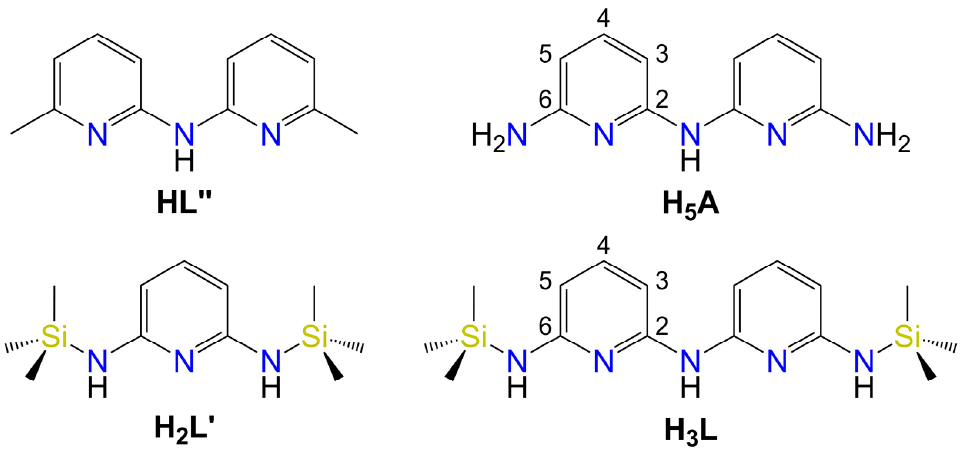
(cid:48)(cid:48) , H (cid:48) , and H 5 A, H 2 L 3